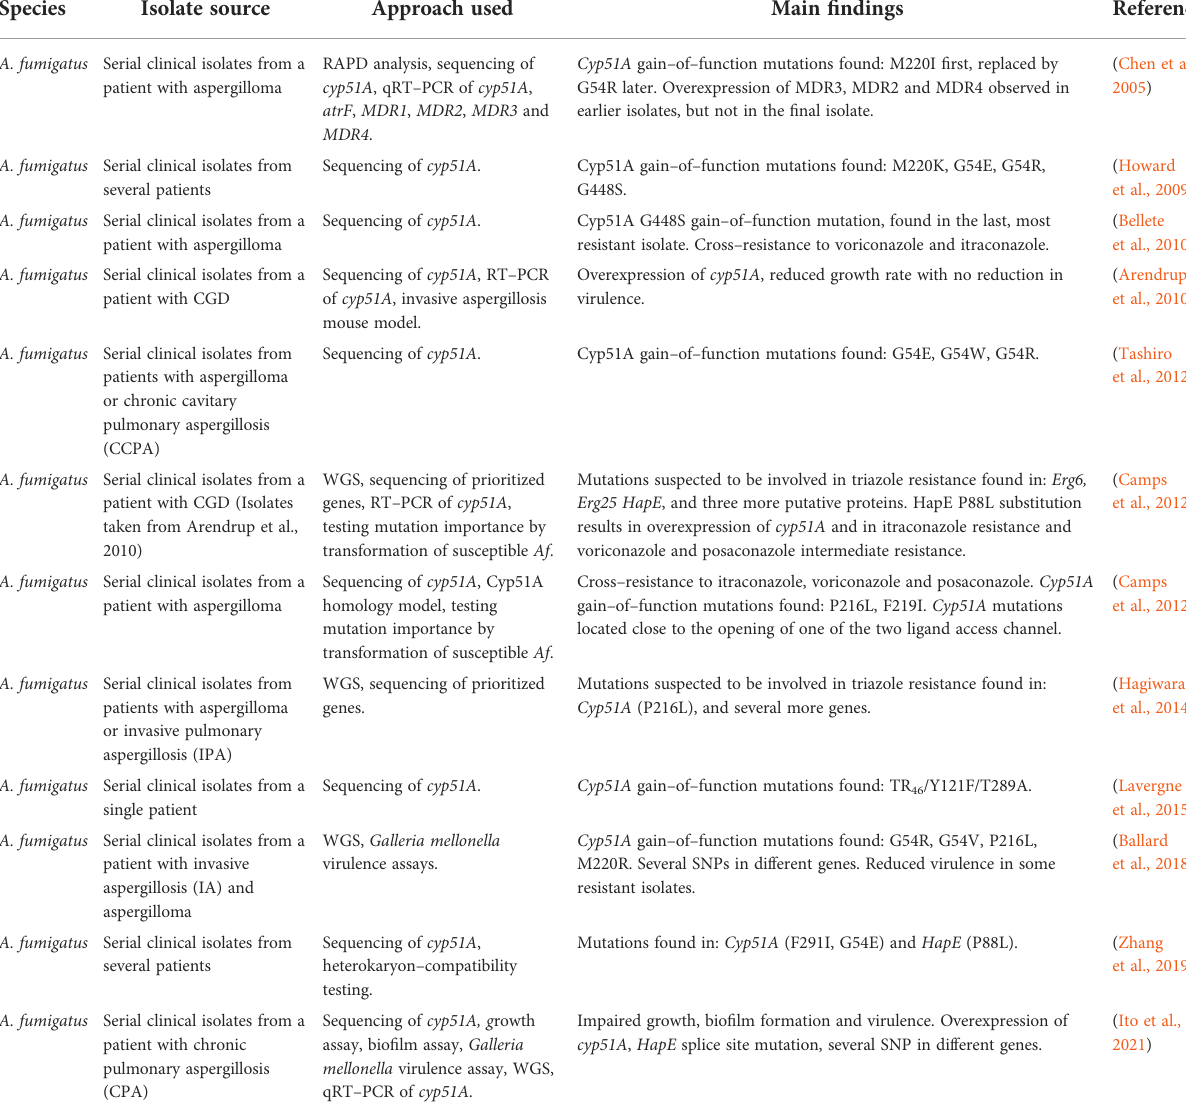
TABLE 6 Development of triazole resistance in serial clinical isolates of A. fumigatus .